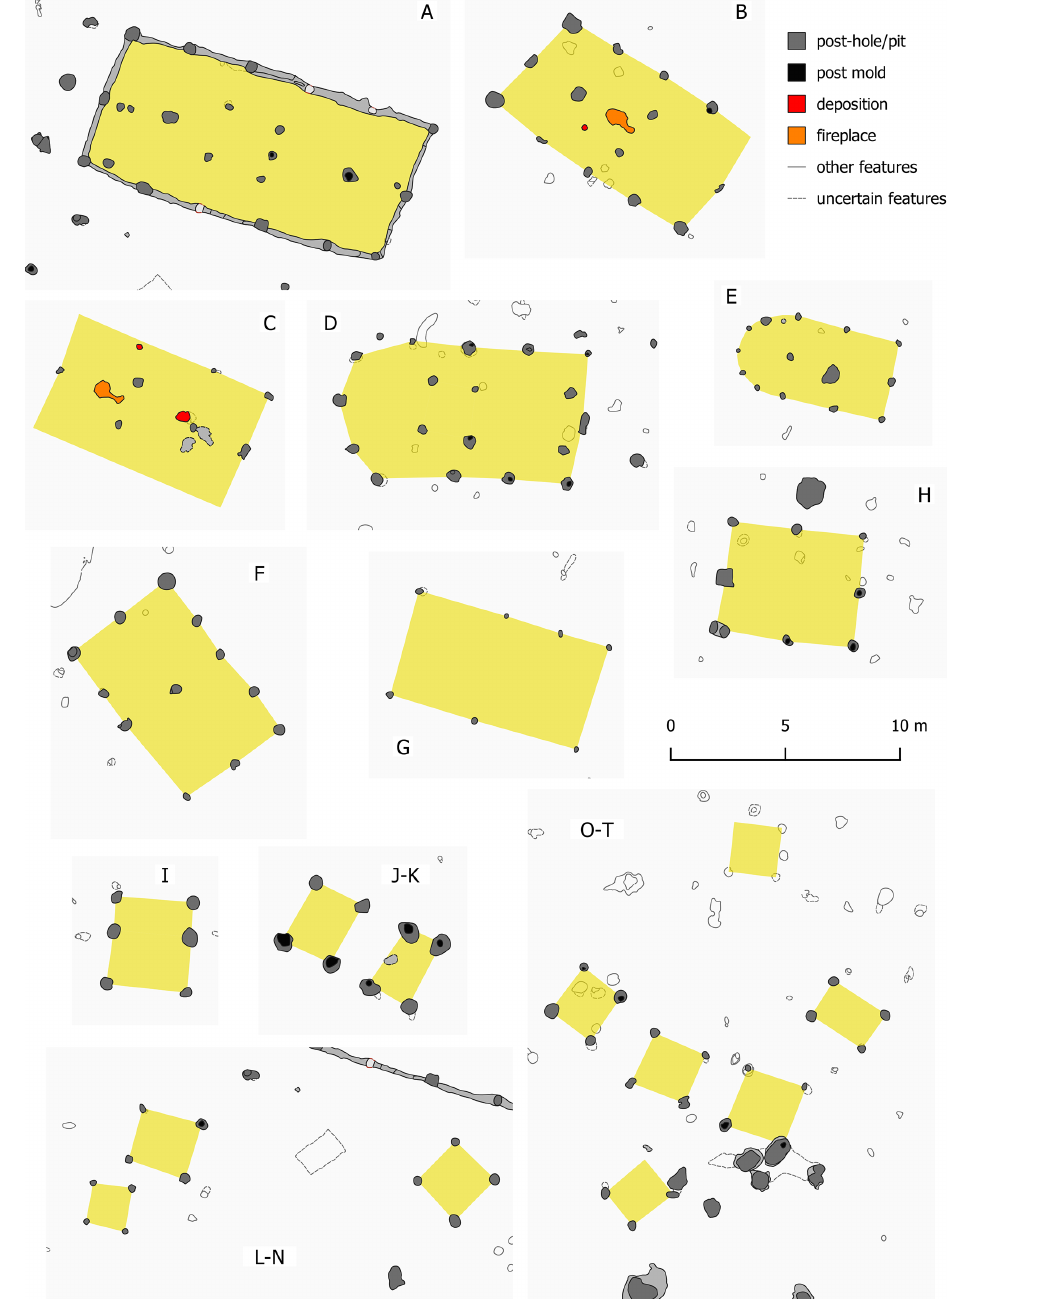
Figure 5. House floor plans of the Middle Bronze Age (MBA) at the Anselfingen excavation.